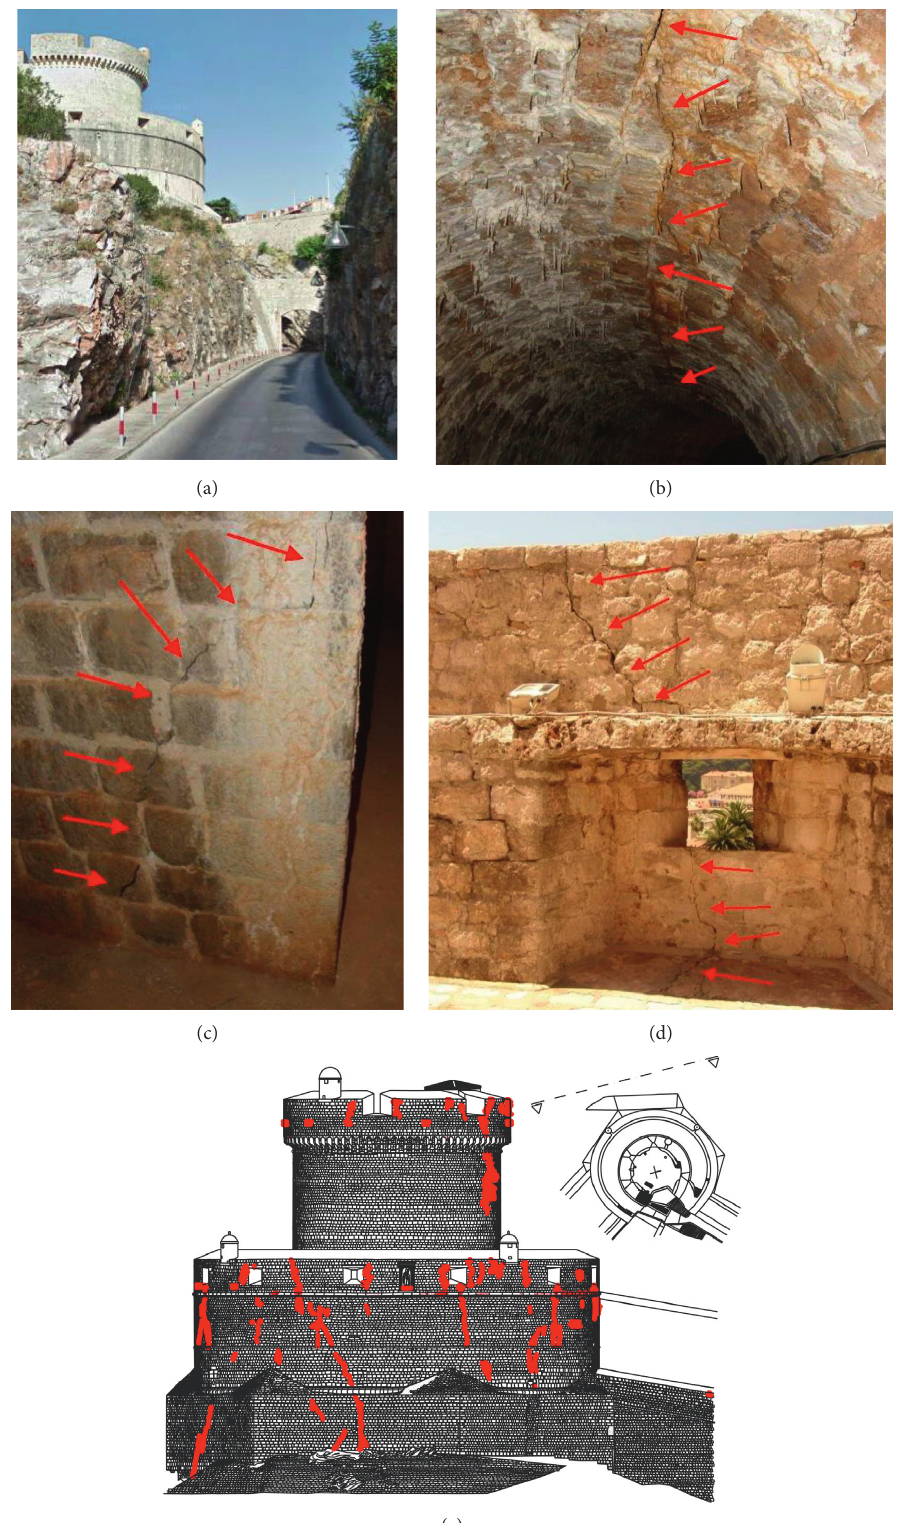
Figure 9: Some defects and damages of the fortress. (a) The deep cut on the northern side of the fortress. (b) Typical cracks in the vaults of the patrol corridors and casemates at the zero level. (c) The broken piece of the wall corner in the peripheral corridor at the zero level. (d) Typical cracks in the prewall around the gun opening above the terrace. (e) The marked cracks in the north-western facade of the